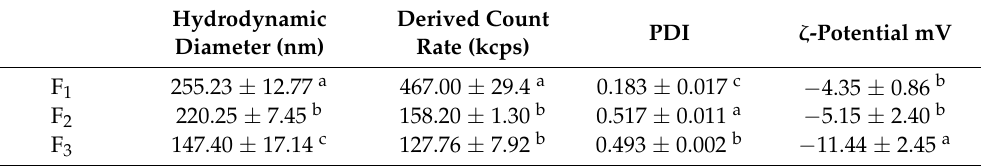
Figure 1. Chromatographic isolation and TEM of CNPs. ( A ) Isolation of the CNPs with a combination of chromatography and DLS. The solid line indicates the UV absorbance, and the dashed line indicates the light scattering intensity. F 1 , F 2 , and F 3 are the three eluents collected at different periods, and are indicated by green arrows, and the range of F 1 is marked by red lines. ( B ) TEM micrograph of the CNPs. Table 1. Colloidal properties of F 1 , F 2 , and F 3 .